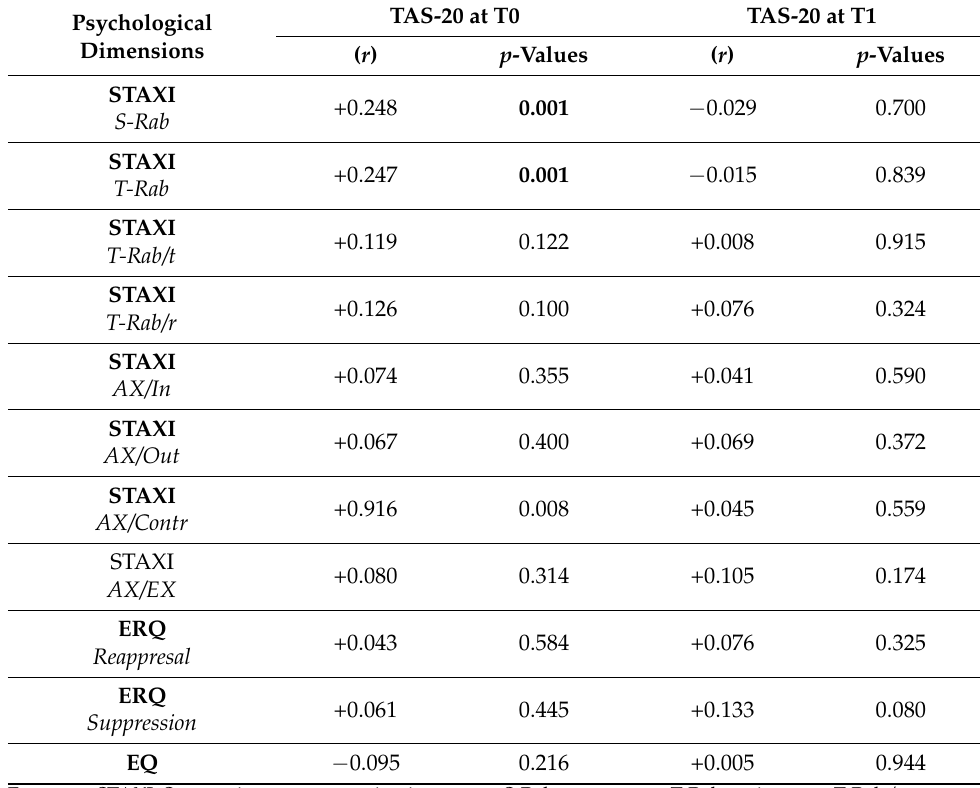
Table 2. Pearson’s correlation ( r ) between Toronto Alexithymia Scale (TAS-20) and psychological dimensions at baseline (T0; before the intervention) and T1 (after the intervention). TAS-20 at T0 TAS-20 at T1 Psychological Dimensions ( r ) p -Values ( r ) p -Values STAXI +0.248 0.001 S-Rab +0.247 T-Rab